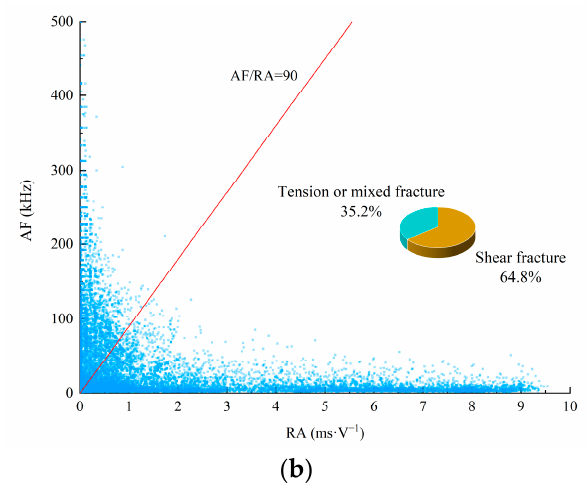
Figure 10. The curve of damage-variable time under a 30 kN dynamic normal load.